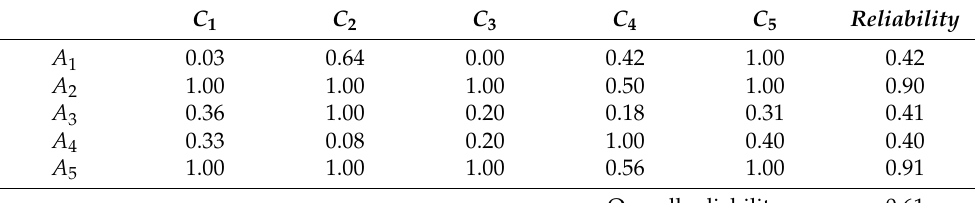
Table 17. The reliability of information obtained from the third of three respondents.